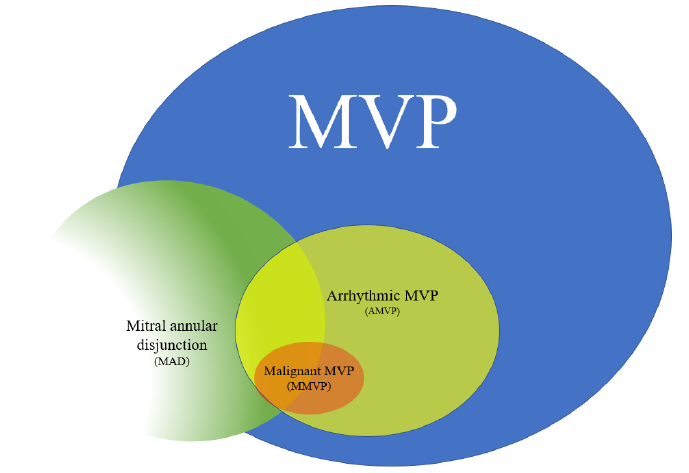
Figure 1. Mitral valve prolapse (MVP) represents a common valve disorder with a subgroup at elevated risk of arrhythmias, referred to as arrhythmic MVP (or AMVP). Within AMVP, there is a subset of patients at risk for developing SCD, termed malignant MVP (or MMVP). Mitral annular disjunction (MAD) has established itself as an important risk factor for AMVP and MMVP.